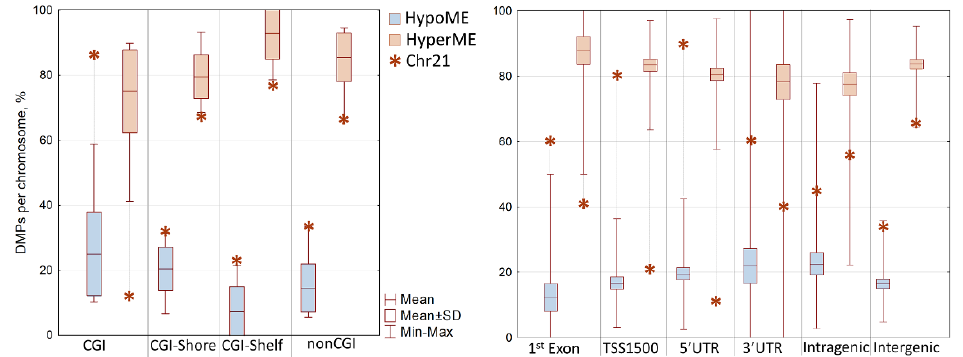
Figure 4. Plots depict the percentage of hypermethylated and hypomethylated DMPs of chromosome 21 relative to the corresponding characteristics of other autosomes; the percentages across different regions—CGIs ( left ) and genic regions ( right )—are shown. The values for chromosome 21 are marked by asterisks. Boxplots show the statistics for the distribution of the percentage of hypermethylated and hypomethylated DMPs—the mean value, maximum, and minimum—for all autosomes except chromosome 21.